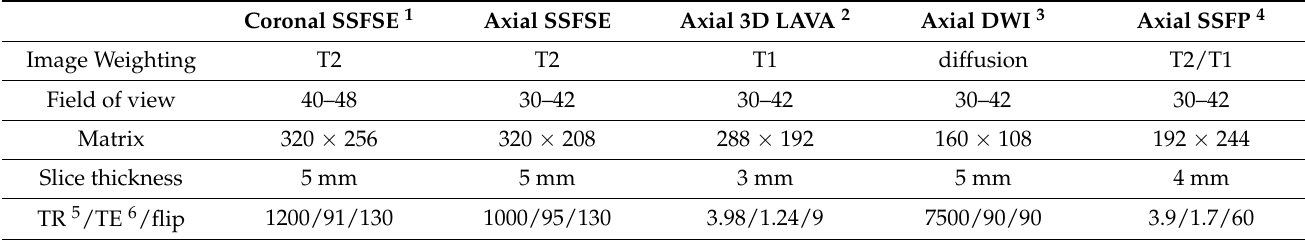
Table 1. MRI imaging parameters.